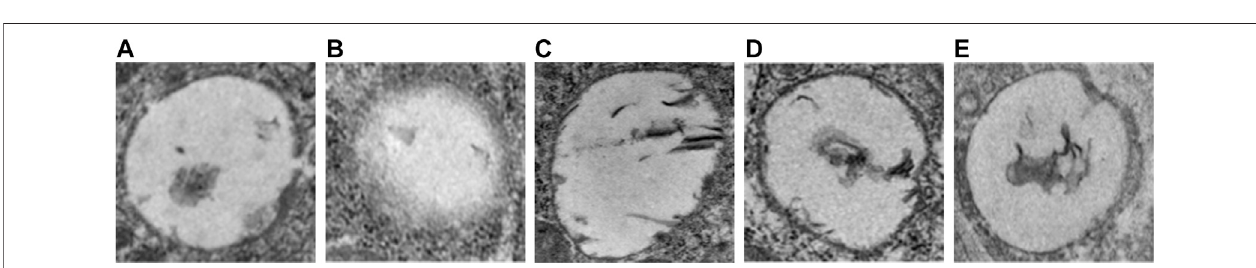
FIGURE 6 | TEM micrograms. Representative cerebral microvascular ultrastructures (x 10,000). (A) DM sham group, (B) DMCI group, (C) FYXN group, (D) Nim & Met group and (E) NC group. An intact cerebral microvascular ultrastructure is shown in DM sham and NC groups, and a disordered cerebral microvascular ultrastructure is illustrated in DMCI, FYXN and Nim & Met groups. Scale bars (cid:2) 200 nm.